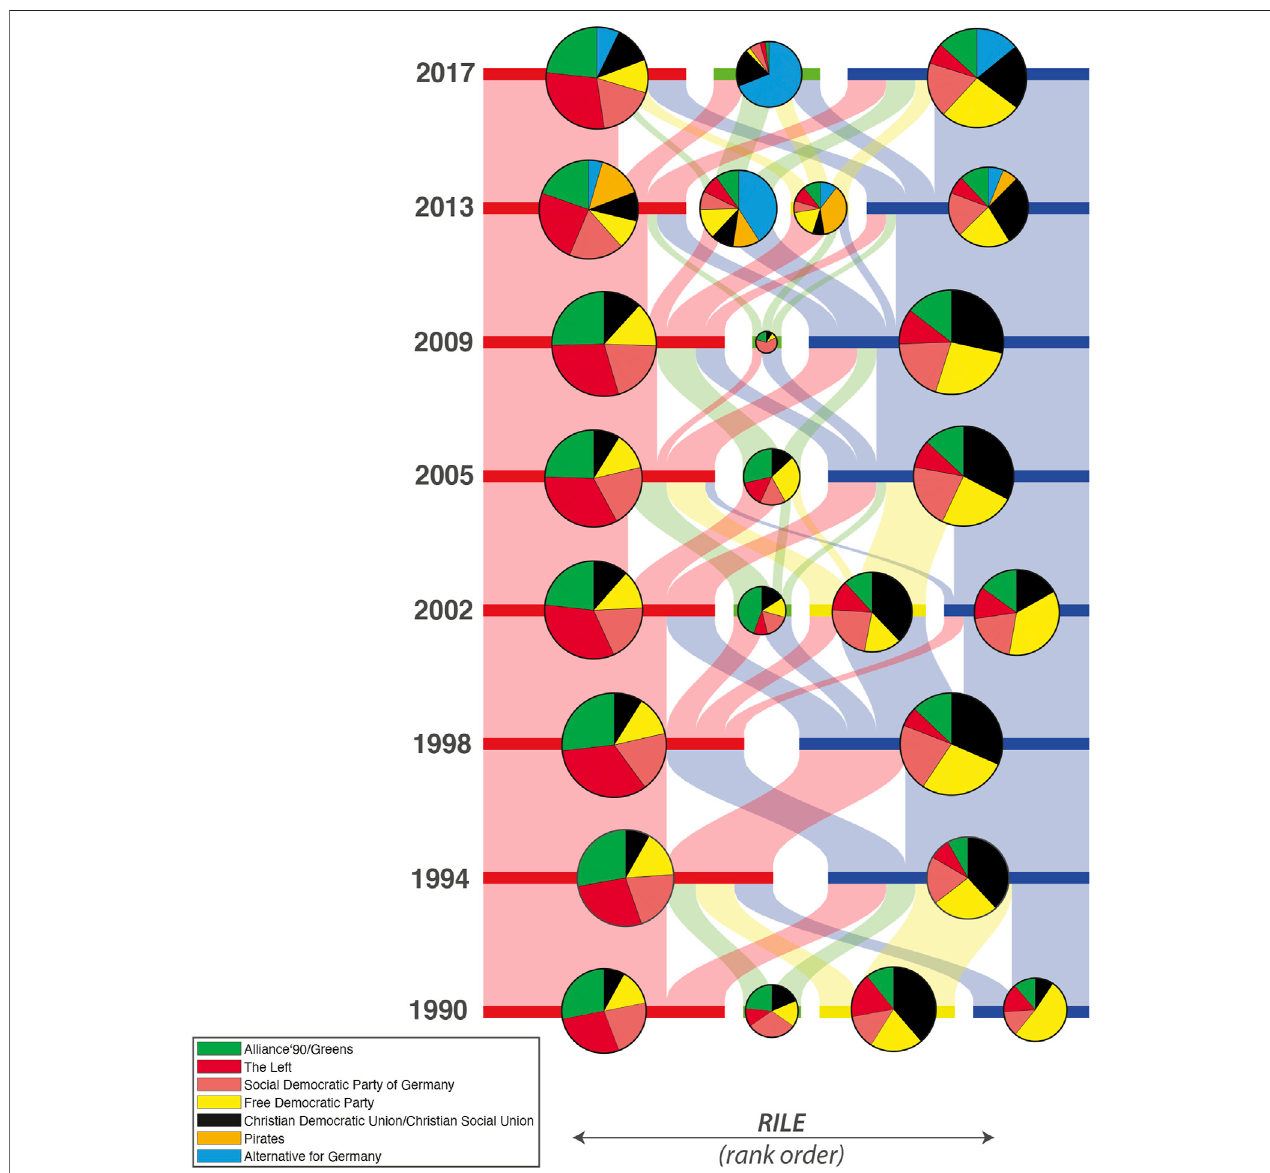
FIGURE 11 | Time evolution of issue bundles (categories) from 1990 to 2017. Bundles are represented by horizontal bars and ordered according to their overlap with the RILE index. For each bundle the coverage by the different parties is shown as a pie chart.